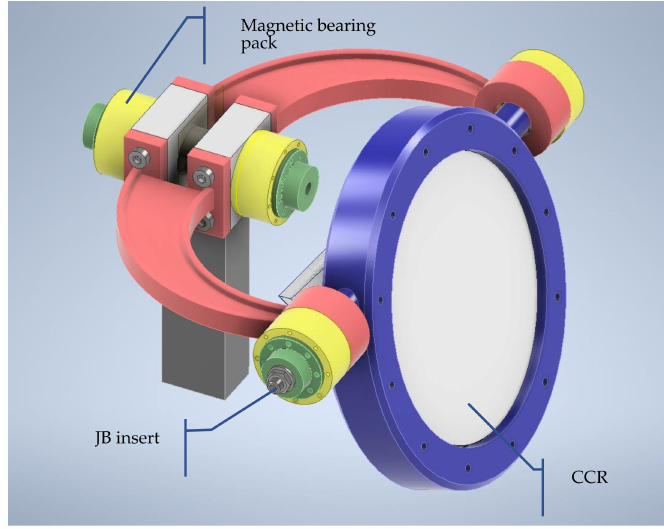
Figure 1. Sketch of the NGLR experiment cardan suspension